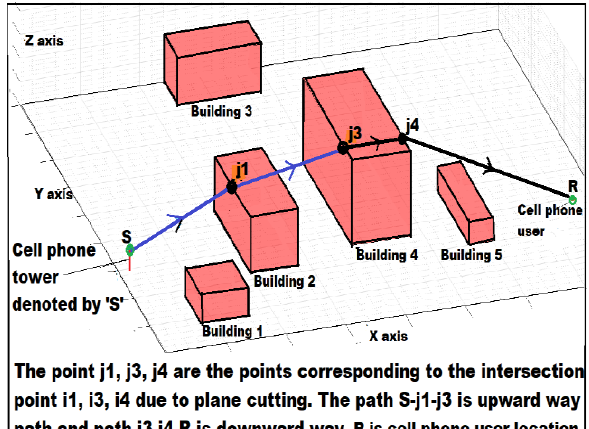
Figure 6. A signal path over the top of